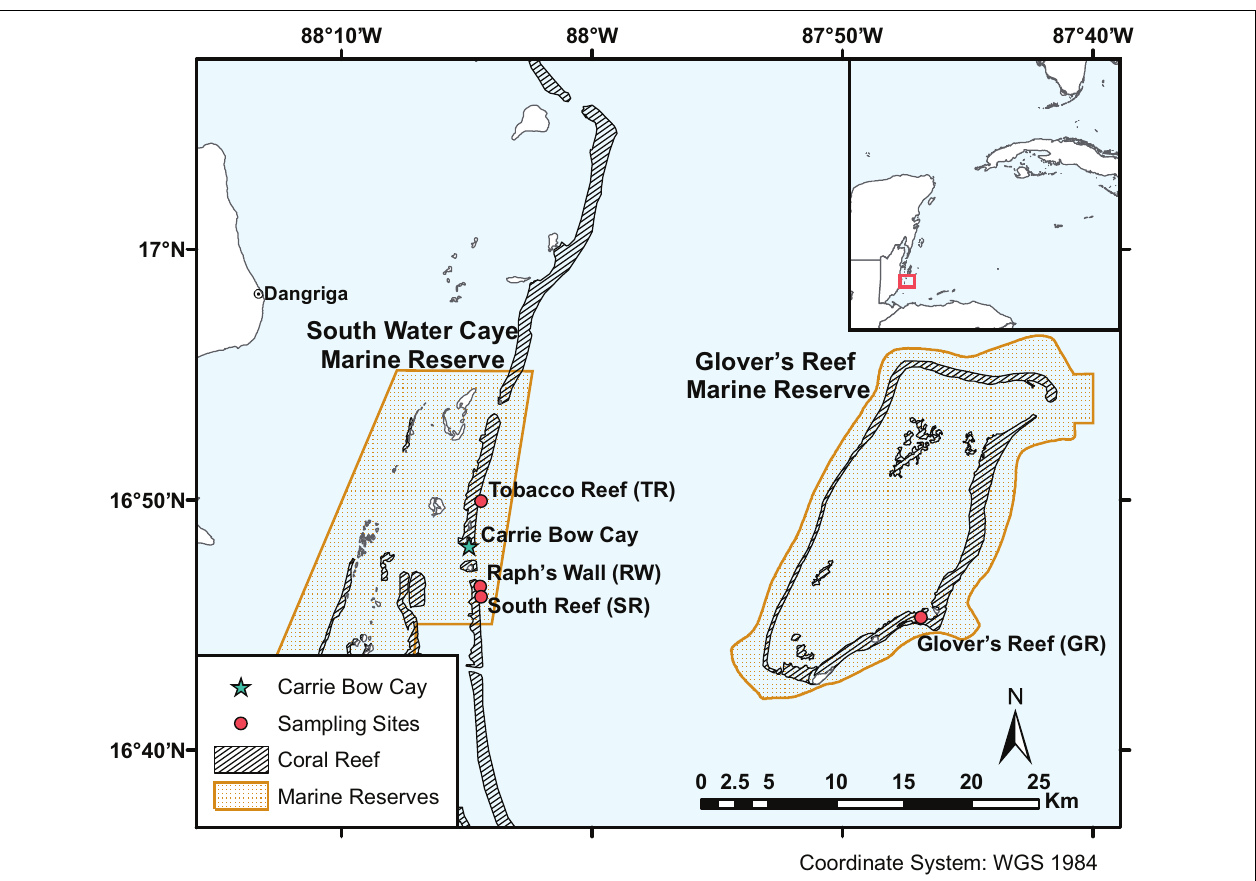
FIGURE 2 | Sampling sites within South Water Caye and Glover’s Reef Marine Reserves on the Belize Barrier Reef. Coral reef habitat and MPA shapefiles adapted from Meerman and Clabaugh (2017).